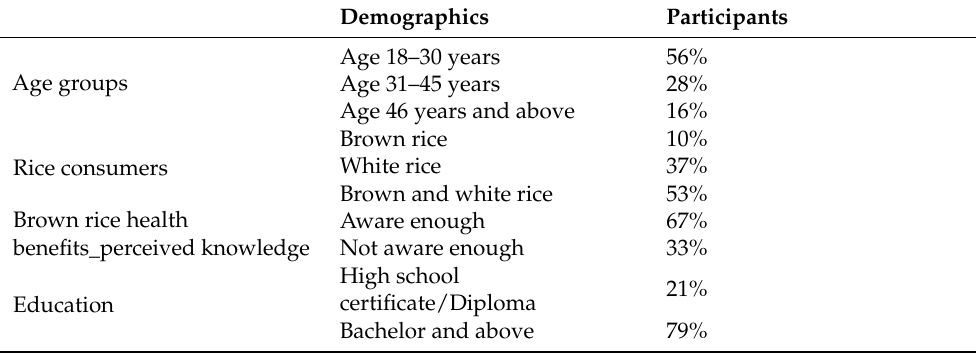
Table 2. Demographics of the participants for the rice tasting